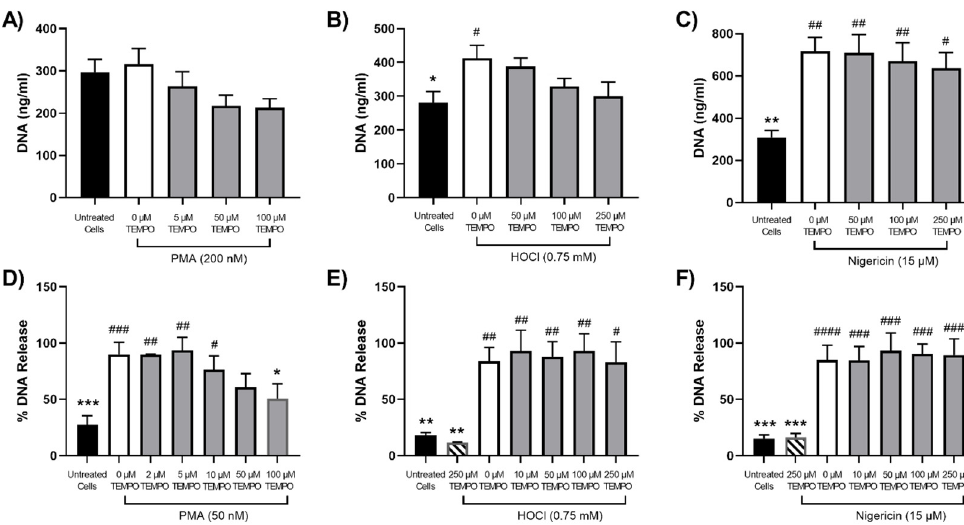
Figure 7. Effect of TEMPO on NET release from neutrophils stimulated with PMA, HOCl or nigericin. Panels ( A – C ): differentiated PLB-985 cells (1 × 10 6 cells) were incubated with TEMPO (5–250 µ M) for 15 min at 37 ◦ C prior to the addition of ( A ) PMA (200 nM), ( B ) HOCl (0.75 mM) or ( C ) nigericin (15 µ M) for 4 h at 37 ◦ C. Panels ( D – F ): primary neutrophils (1 × 10 6 cells) were incubated with TEMPO (2–250 µ M) for 15 min at 37 ◦ C prior to the addition of ( D ) PMA (50 nM), ( E ) HOCl (0.75 mM) or ( F ) nigericin (15 µ M) for 3 h at 37 ◦ C. Following treatment, NETs were released by the addition of DNase (40 U) for 15 min and quantification of extracellular DNA using a Quant-iT TM PicoGreen TM dsDNA Assay kit. Data are presented and analysed as described in Figure 4.